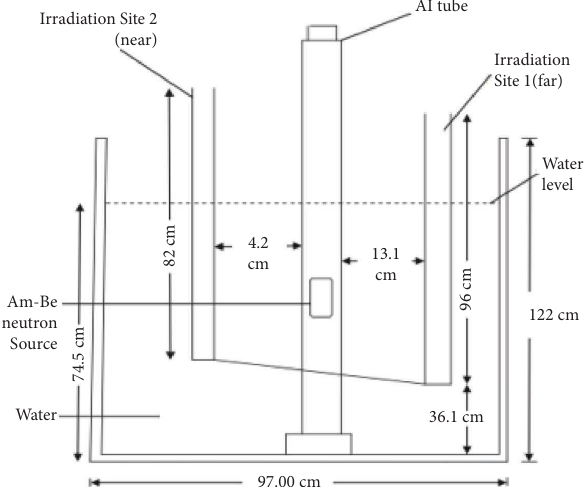
Figure 1: Schematic longitudinal view of 241 Am-Be neutron source [12].